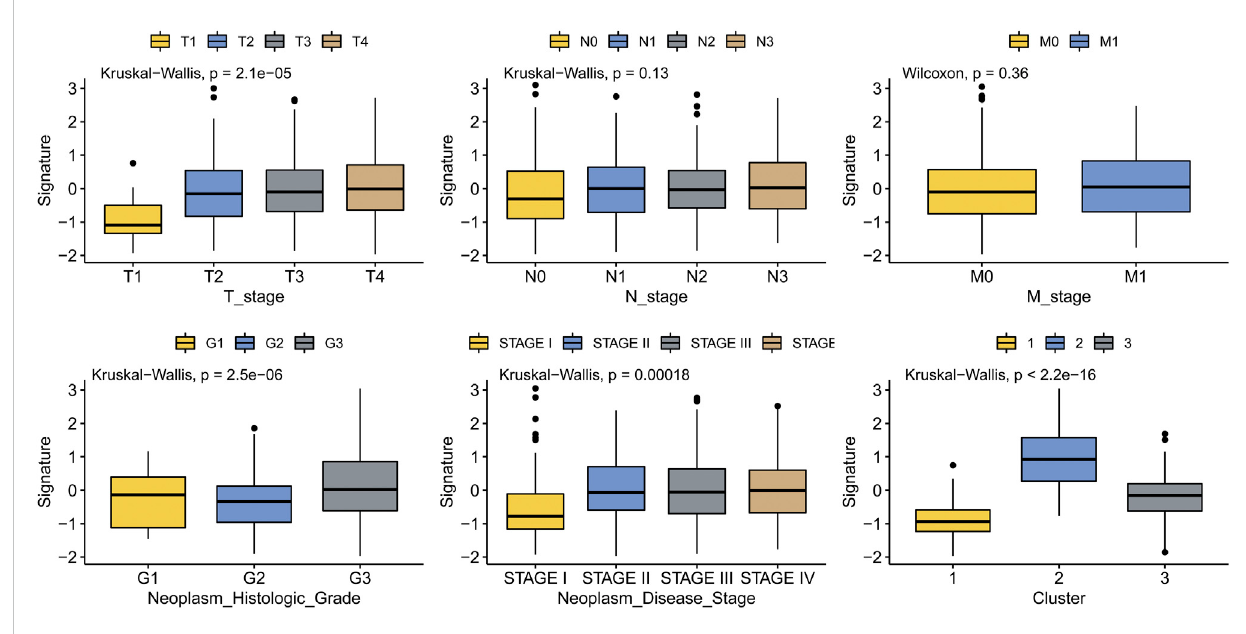
FIGURE 4 Association of MMP scores with clinicopathological features in patients with gastric